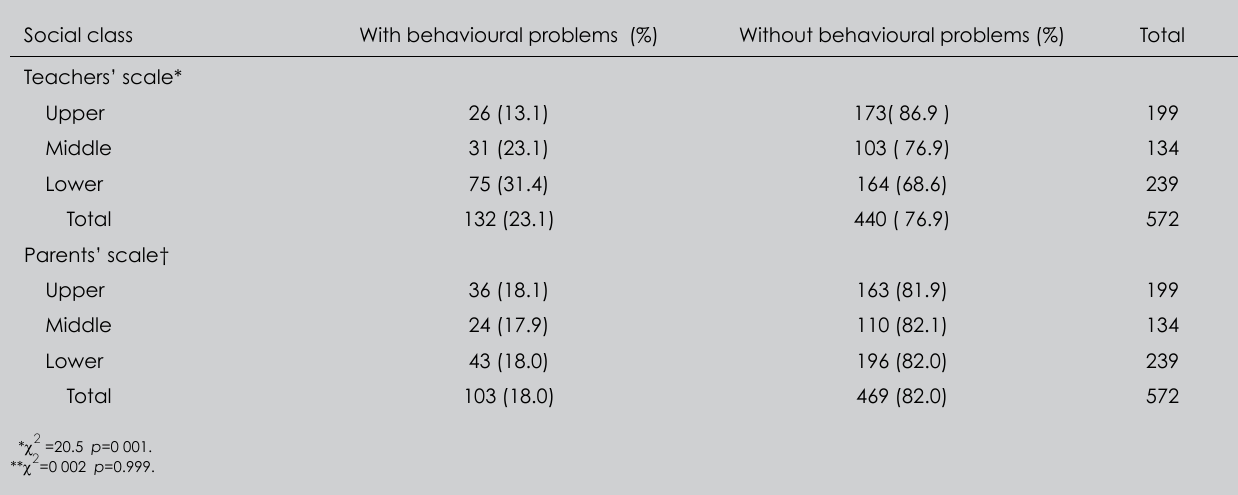
Table III. Distribution of subjects within social class according to both scales Social class With behavioural problems (%)